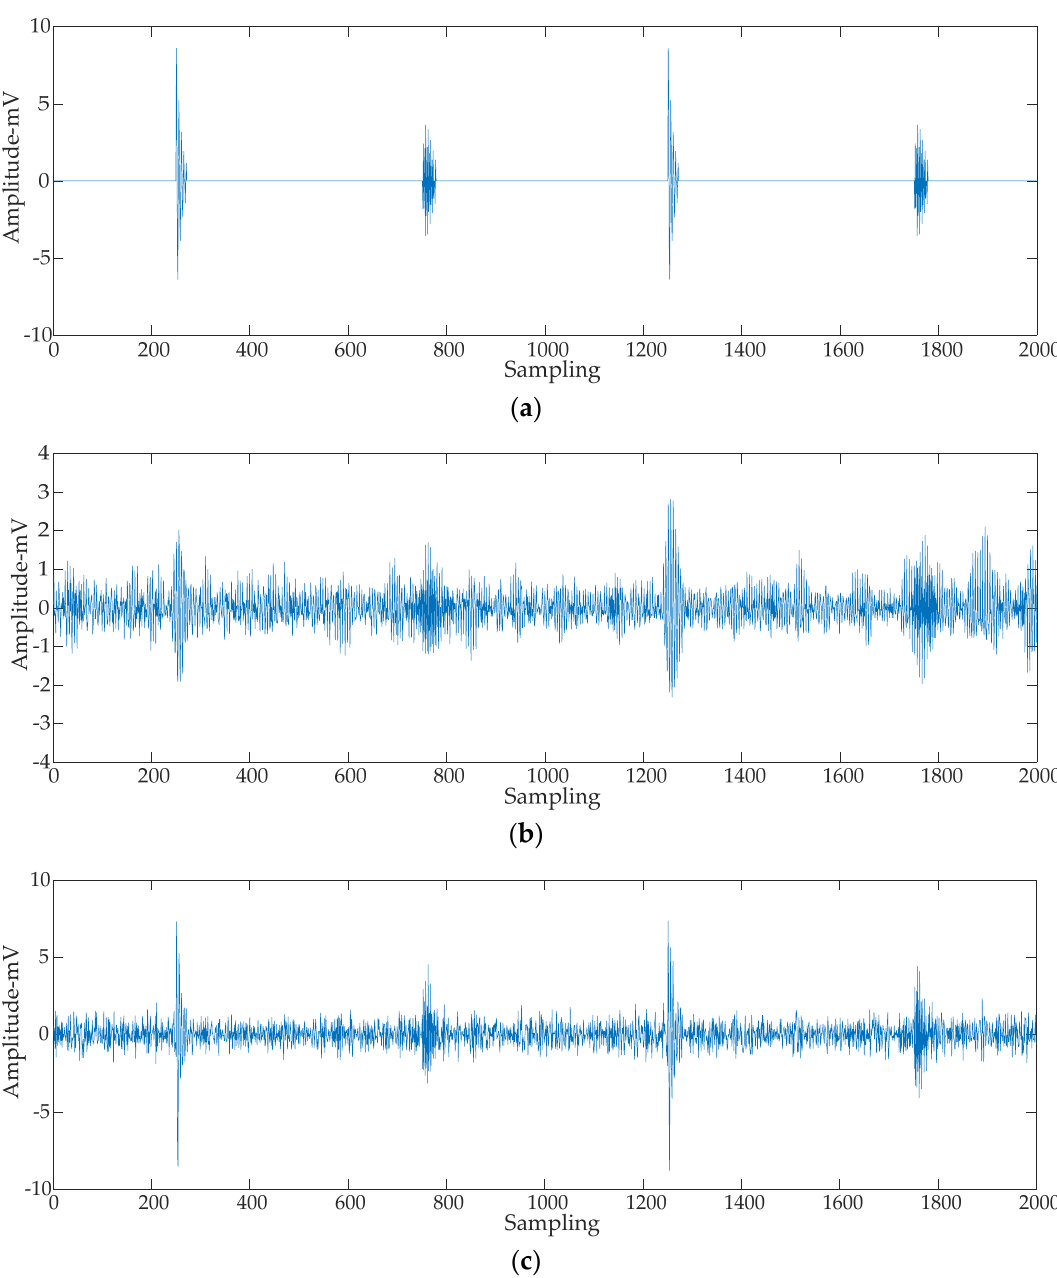
Table 3. Denoising evaluation of simulation signal results.